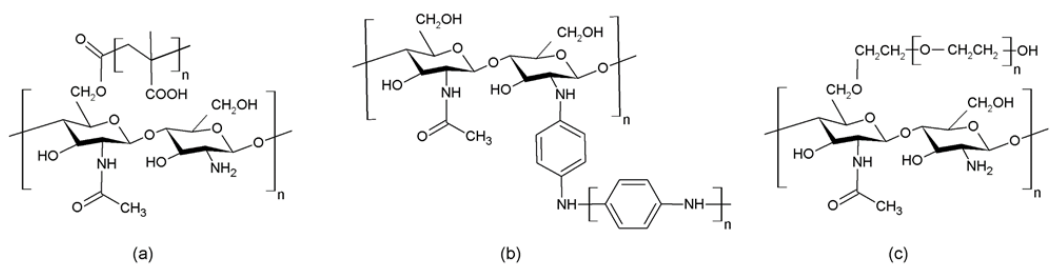
Figure 5. Some examples of chitosan graft copolymers: ( a ) chitosan/PMMA, ( b ) chitosan/PANI and ( c ) chitosan/PEG.